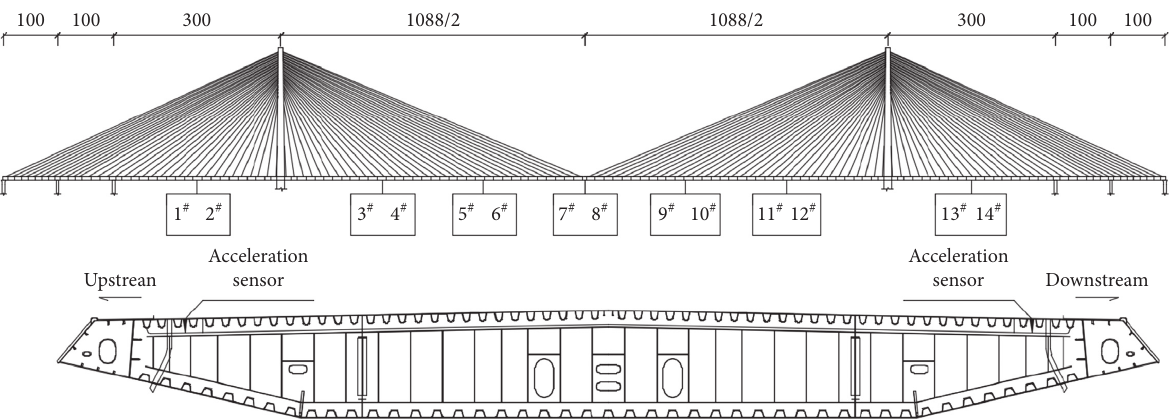
Figure 12: Acceleration sensor